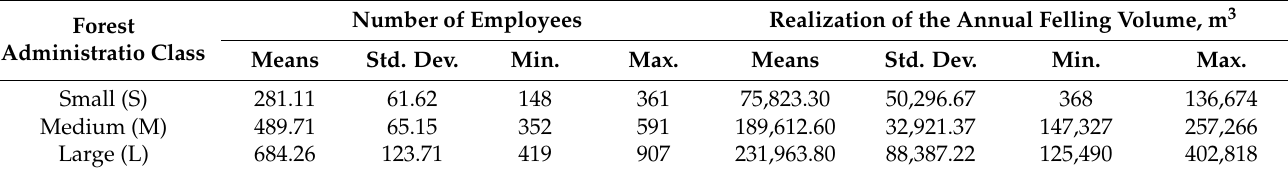
Table 1. Key descriptive values for classification of Forest